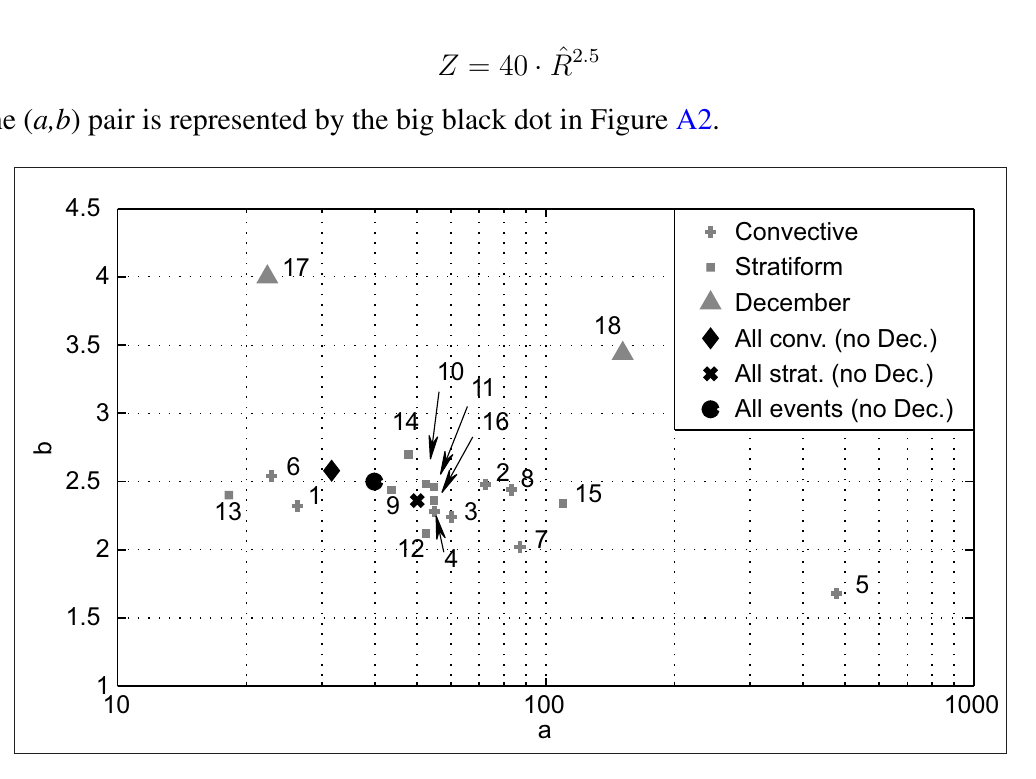
Figure A2. Optimal ( a - b ) values of the Z-R relation for each single event (grey symbols, according to event type), for the different event categories (black rhombus and cross) and for the whole set of events (black